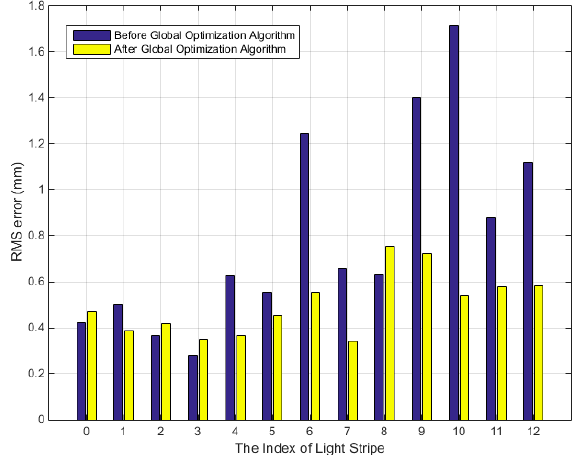
Figure 12. RMS errors of the distances between 3D points on light-stripes and the fitted plane before and after global optimization.